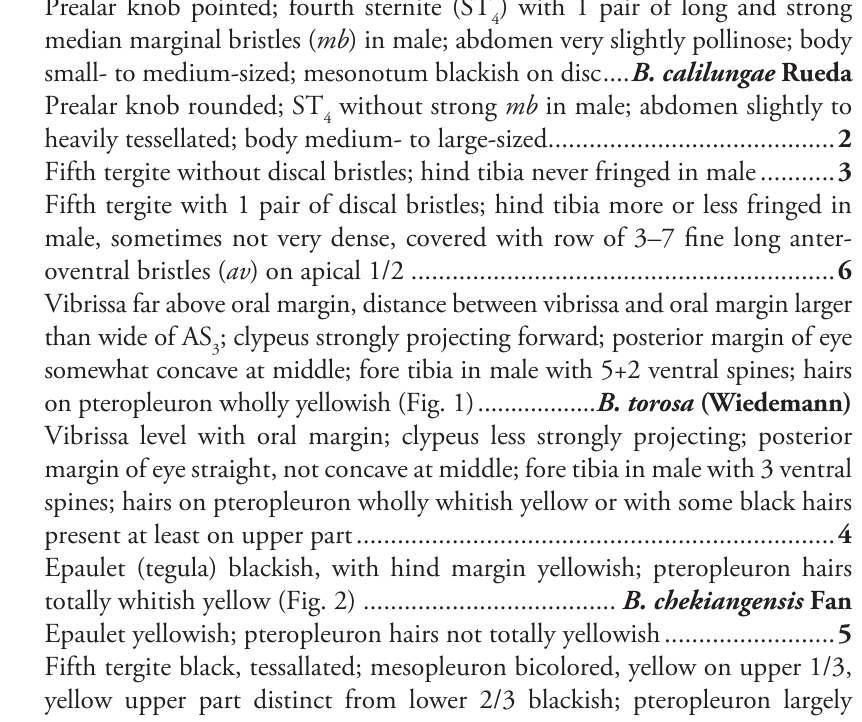
5 Fifth tergite black, tessallated; mesopleuron bicolored, yellow on upper 1/3, yellow upper part distinct from lower 2/3 blackish; pteropleuron